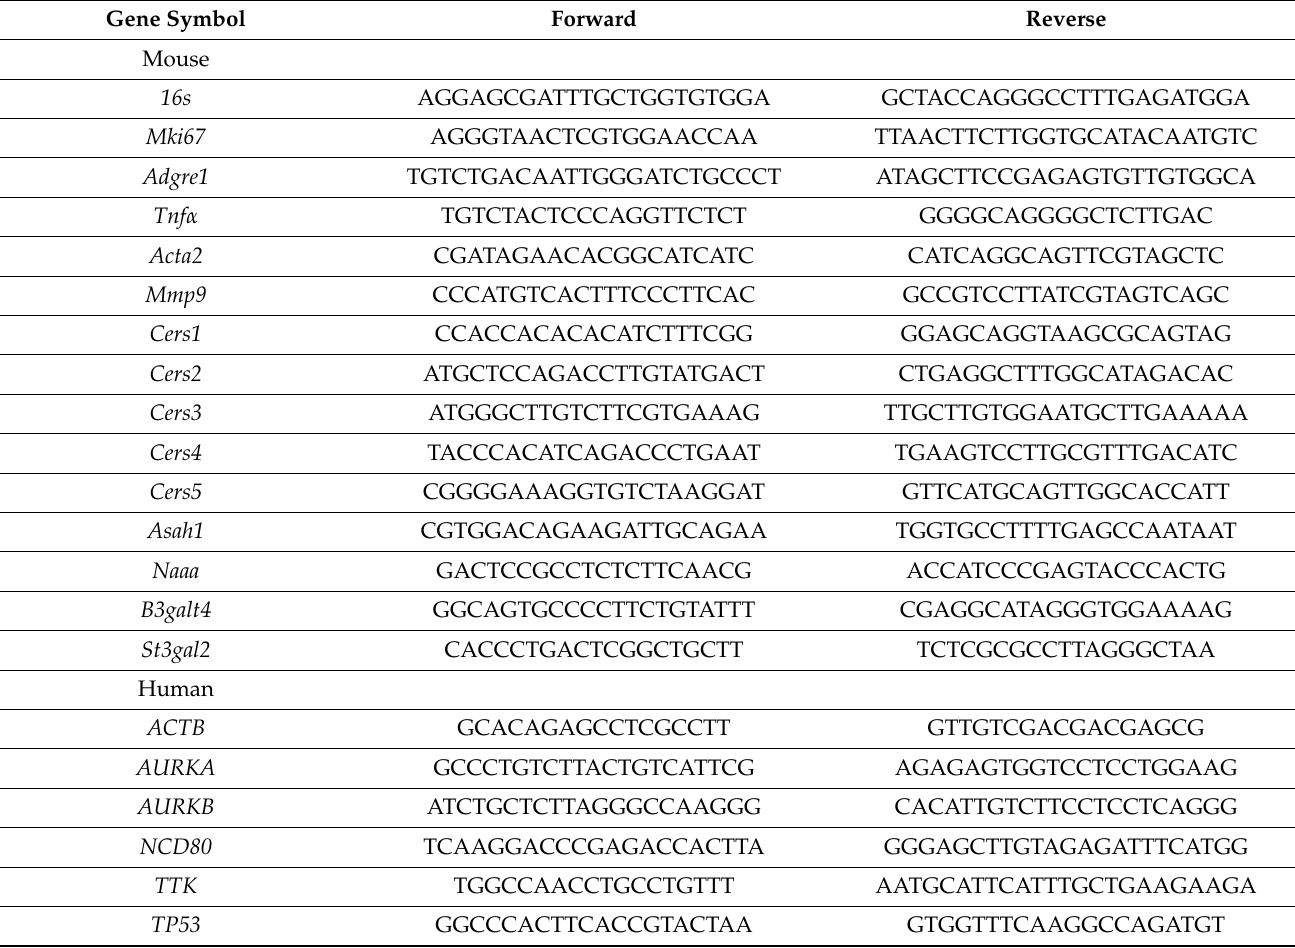
Table 1. Primer sequences used in this